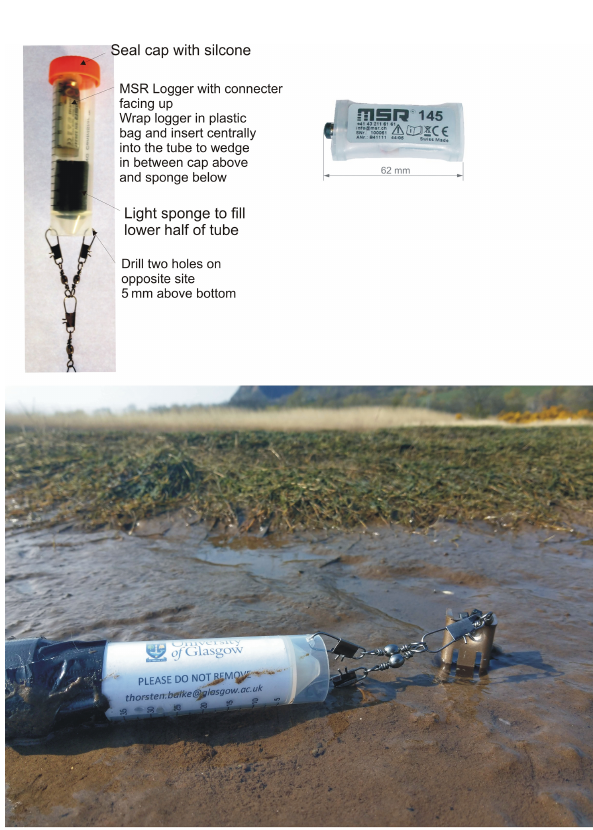
Figure A1. Mini Buoy components and